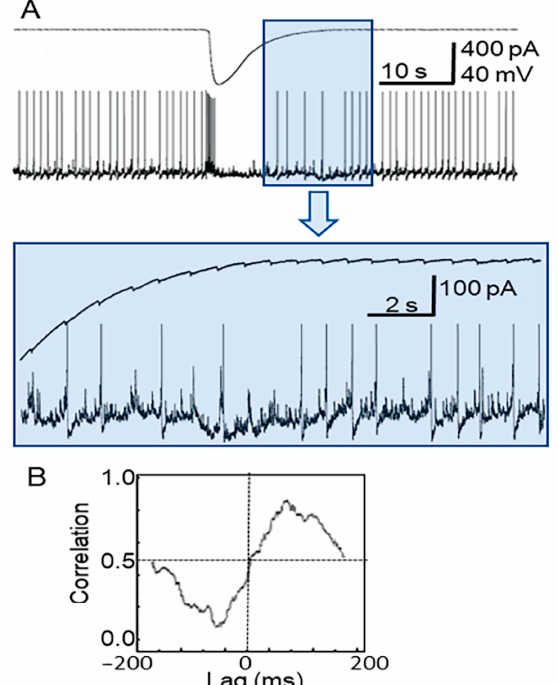
Figure 3. ( A ) Simultaneous patch-clamp current recordings of an astrocyte (upper trace, pA) and a neuron (lower trace, mV) corresponding to the seizure-like event elicited by 4-AP. The colored insert (above) shows the same recording at greater time and amplitude resolution. ( B ) Cross correlation function (CCF) graph of recordings in ( A ) with a value of +0.88 at lag time = 100 ms.